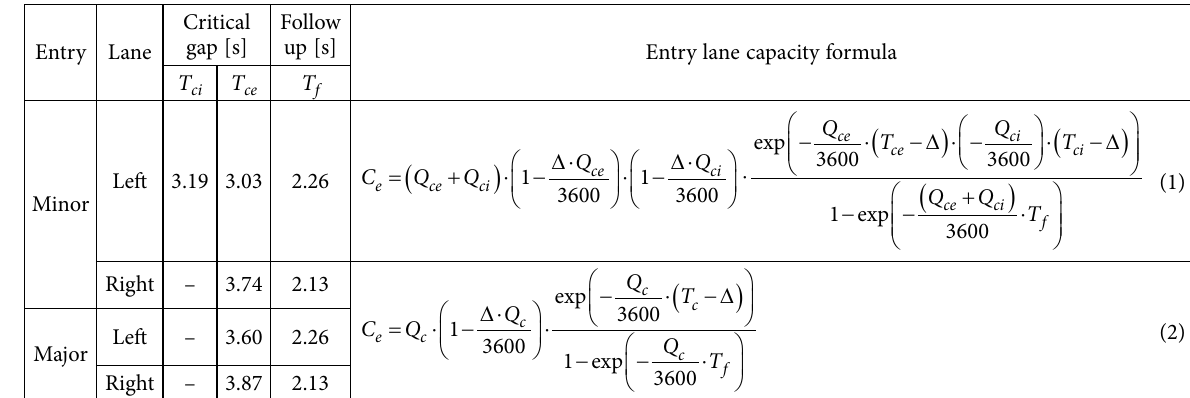
Table 1. Gap acceptance parameters and capacity formulas at turbo-roundabout